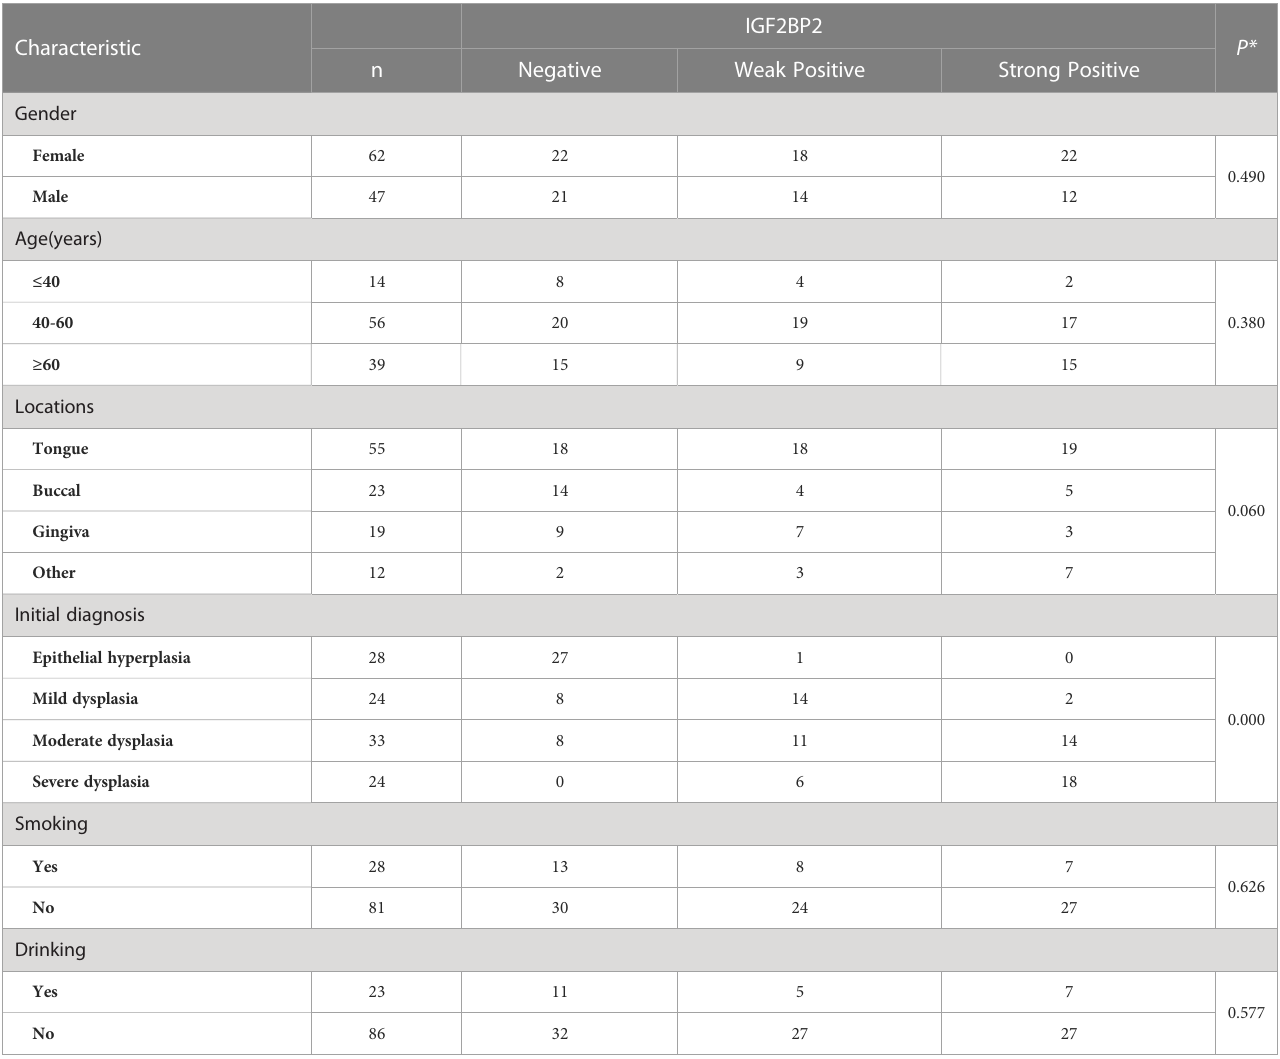
TABLE 4 Association between the clinicopathological characteristics and IGF2BP2 expression in 109 cases of OSCC and OED.